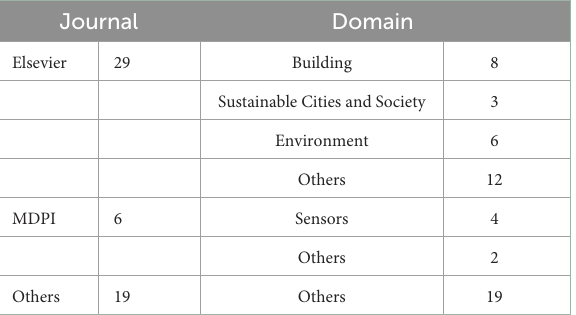
TABLE 3 Classification data references present in the corpus.